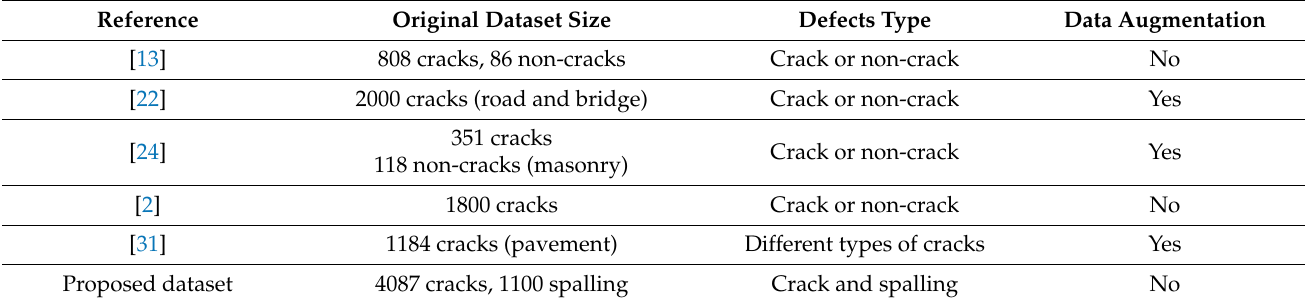
Table 1. Dataset comparison of prior studies and current study.